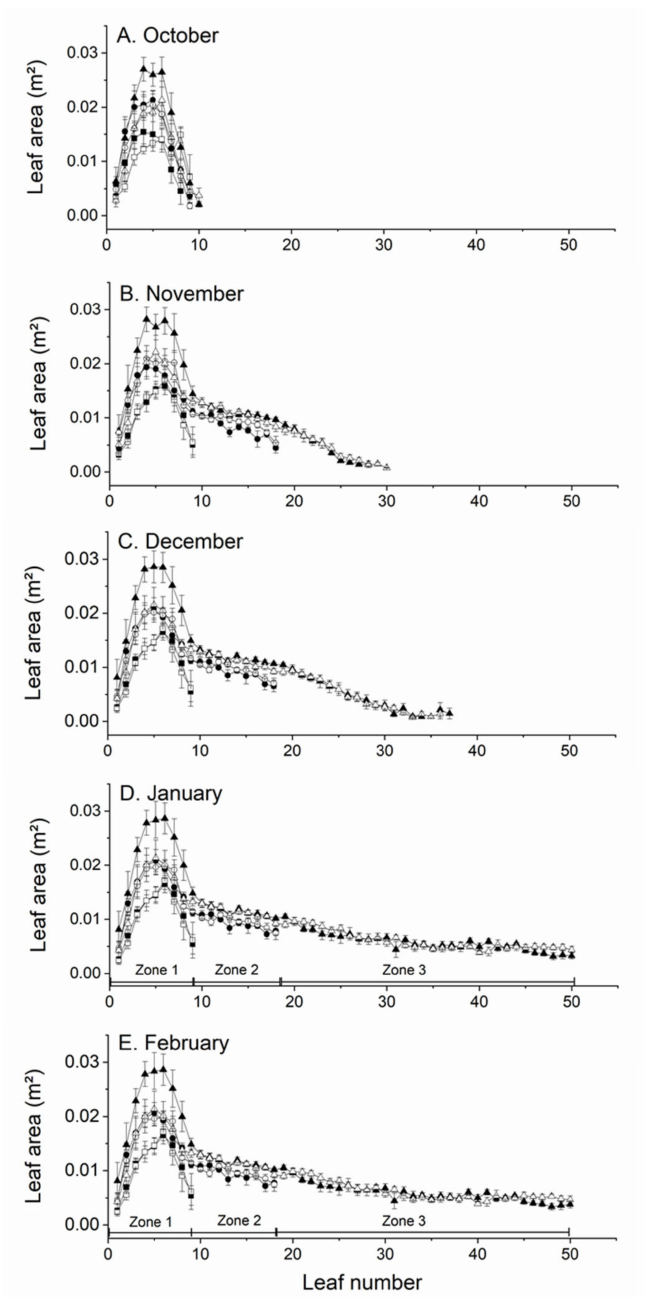
Figure 4. The effect of shoot type and rootstock on mean leaf area at different nodal positions along shoots Actinidia chinensis var. chinensis ‘Zes008’ in ( A ) October, ( B ) November, ( C ) December, ( D ) January, and ( E ) February during the growing season. Shoots were growing on vines with either A. chinensis var. deliciosa ‘Bruno’ rootstock (short (cid:4) , medium • or long (cid:78) shoots) or an A. macrosperma rootstock (short (cid:3) , medium or long (cid:52) shoots). Leaves 1–9 were in Zone 1, leaves 10–18 were in (cid:35) Zone 2 and leaves 19 and greater were in Zone 3. Data are means ± SEM, n =